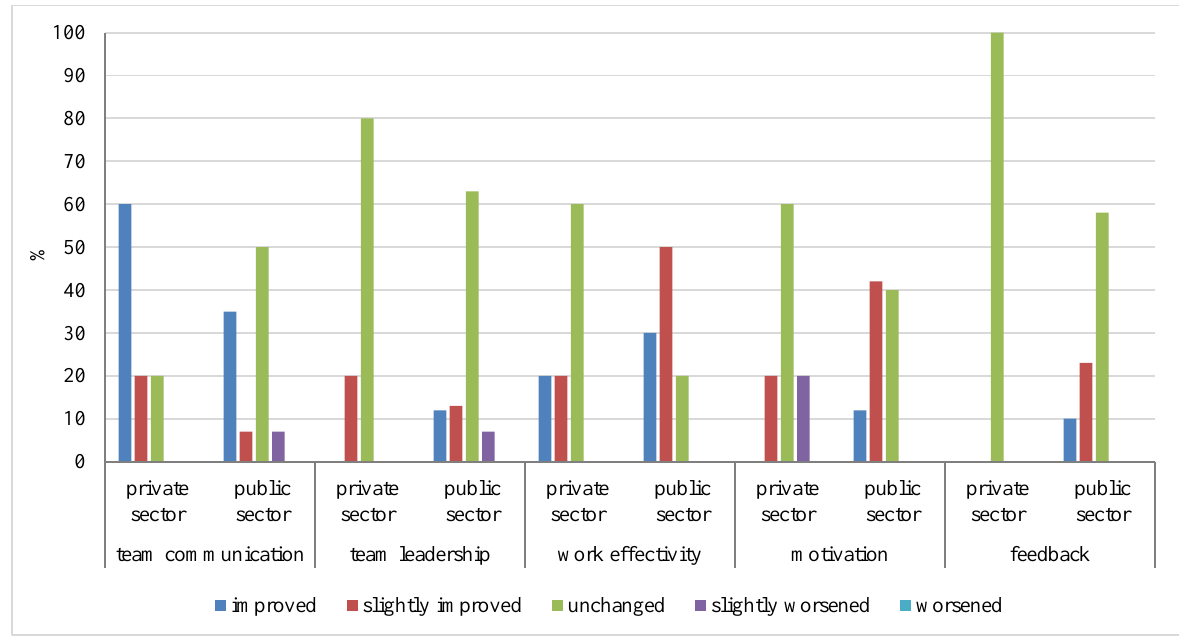
Figure 5. Impacts of increased home office.